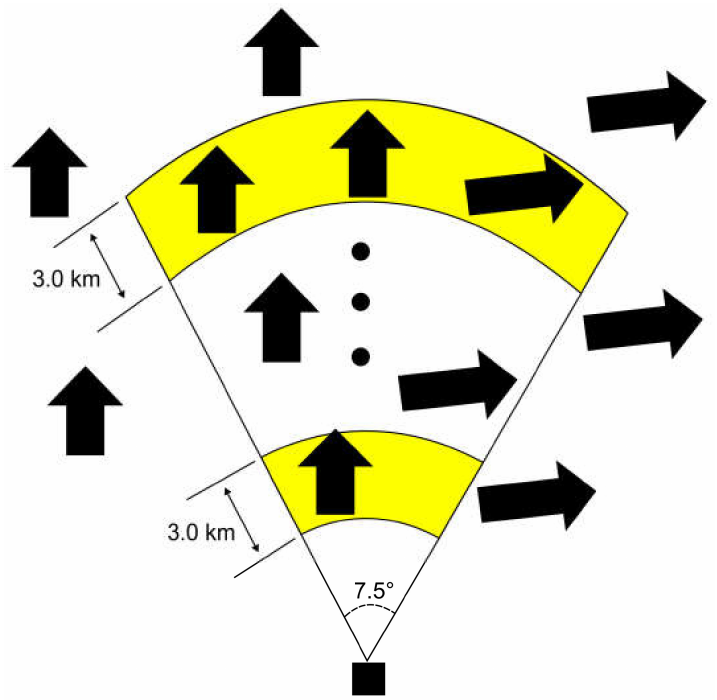
Figure 11. Variation with distance of the observation cell size and the existence of two currents. The square represents the position of the radar station, the black arrows represent two currents with different directions, and the yellow area represents the image of the observation cell size. There are two currents in the observation cell at far distances, while there is only one current in the observation cell at a short